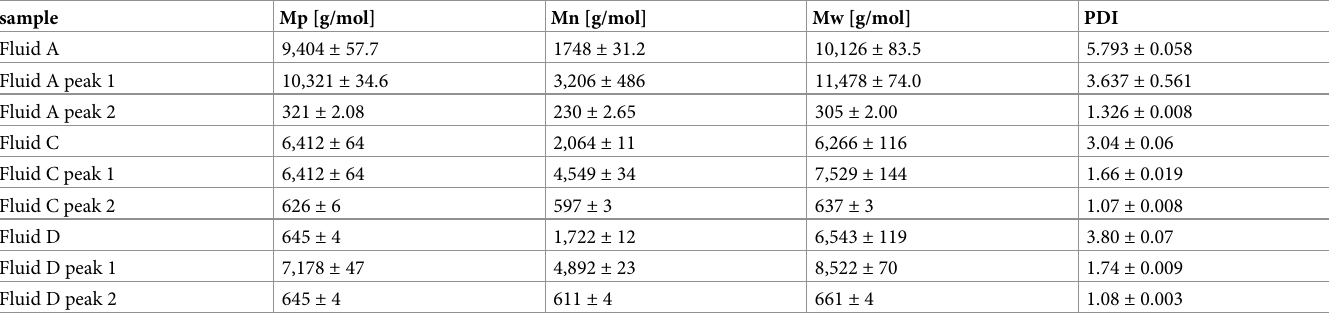
Table 1. Summary of molecular weight moments and polydispersity.